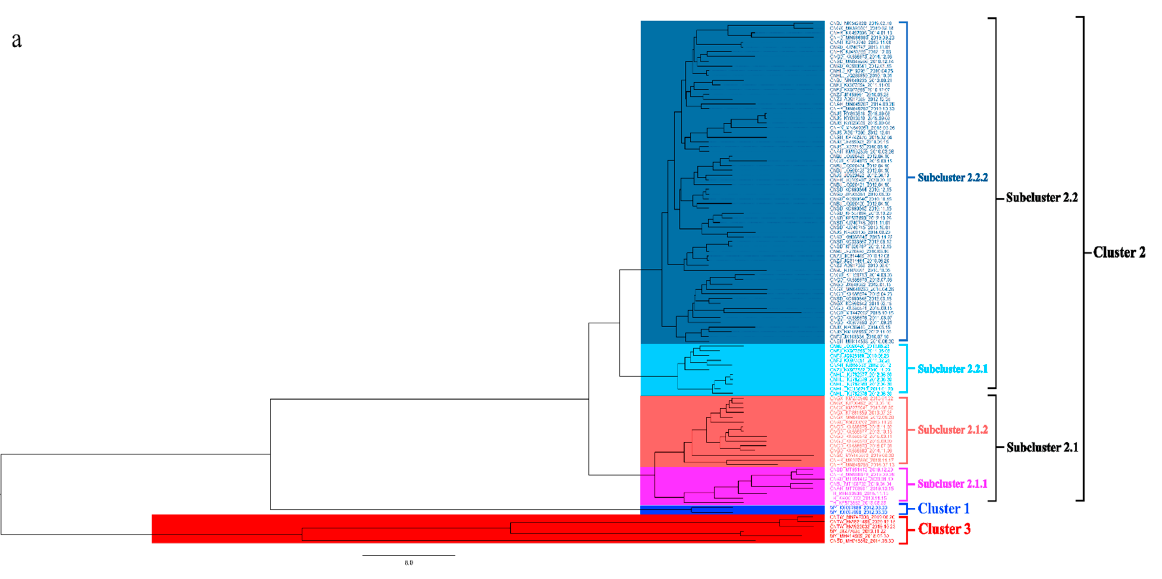
Figure 2. A Bayesian skyline plot exhibiting the effective population size change for the E gene of TMUV. A measure of group change is shown on the y -axis with 95% HPD (blue).